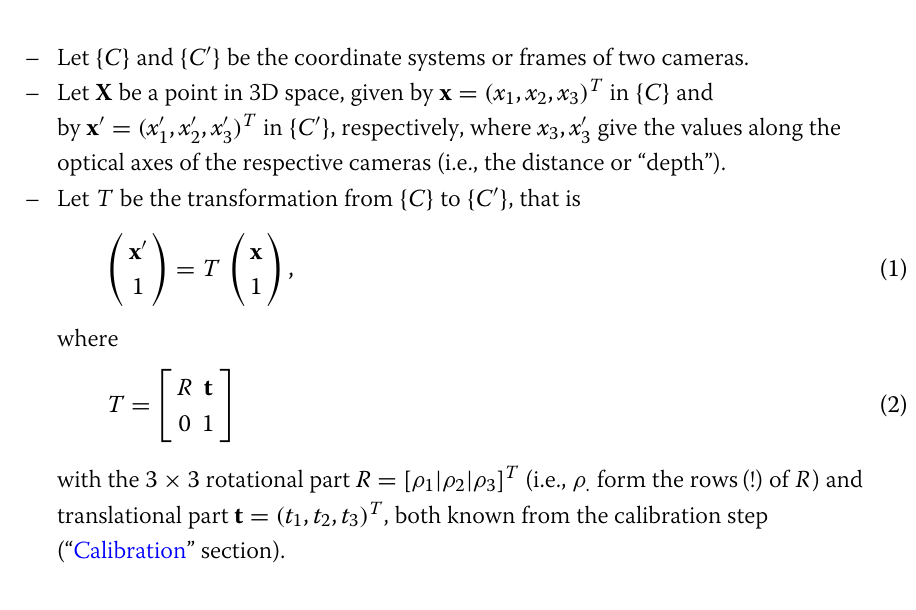
a b Fig. 8 a Single pinhole of our multi-pinhole collimator, its field of view (2 × α ) defined by width w and height h . The wider field of view of the aligned camera is drawn in comparison. b Rendering of the micro camera placement layout with respect to the pinholes (camera fixation frame not shown). The collimator is pointing towards the source (red arrow)